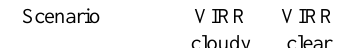
Table 6. Accumulated results of the proposed algorithm for POD, FAR, and HR validation scores during four seasons. Corresponding values are given for the VIRR official products in